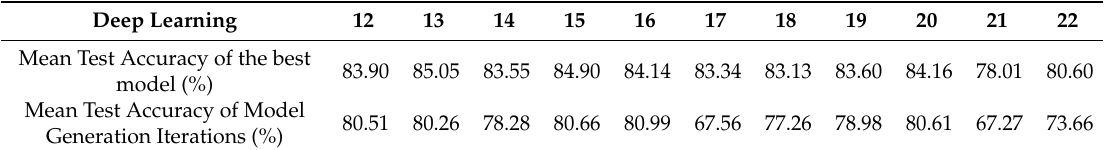
Table 3. Deep-learning test accuracy results (2 / 2).